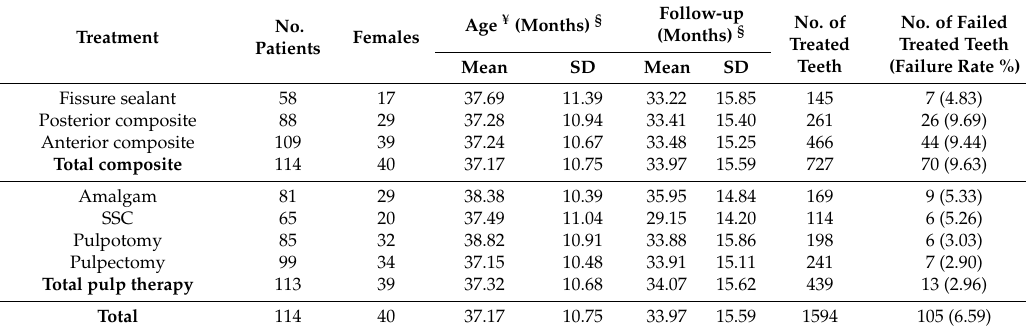
Table 2. Failure rate of each treatment